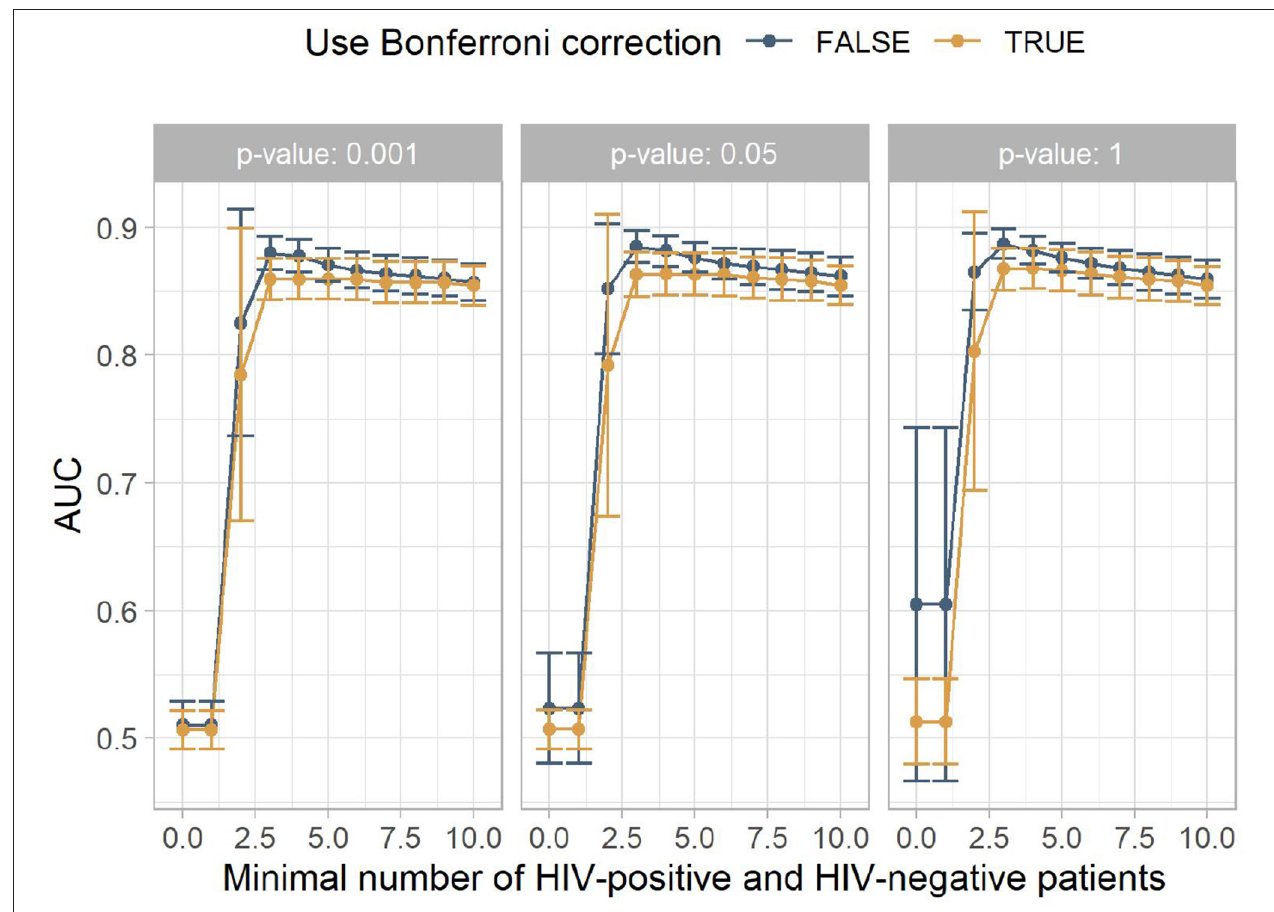
FIGURE 2 | The mean area under the receiver operating characteristic curve (AUC) for the different experiment configurations. The x-axis shows the minimum number of HIV-positive and HIV-negative patients, the facets show different p -value thresholds, the color indicates if Bonferroni correction was used, and the y-axis shows the mean AUC achieved by this configuration, with the error bars indicating plus/minus one standard